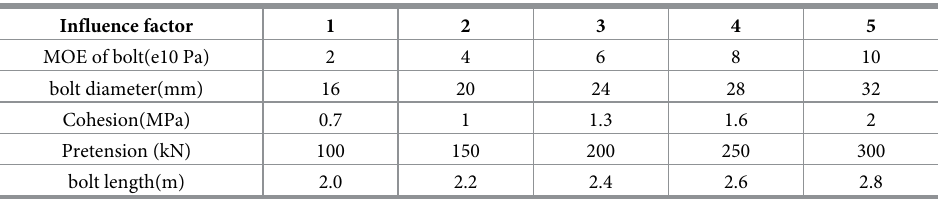
Table 2. Simulation